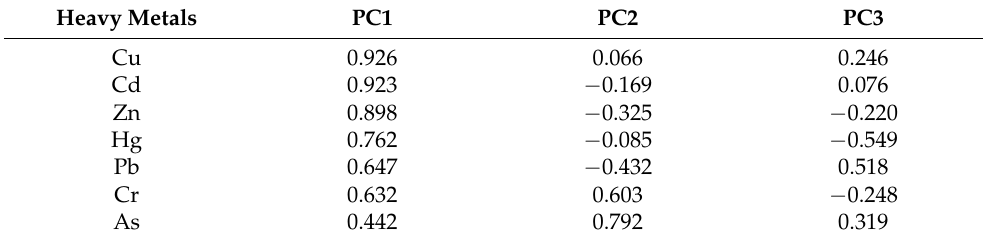
Figure 4. Principal component analysis (PCA) of heavy metals in sediment sampling sites. Table 5. The interpretation variance of heavy metals on three principal components.